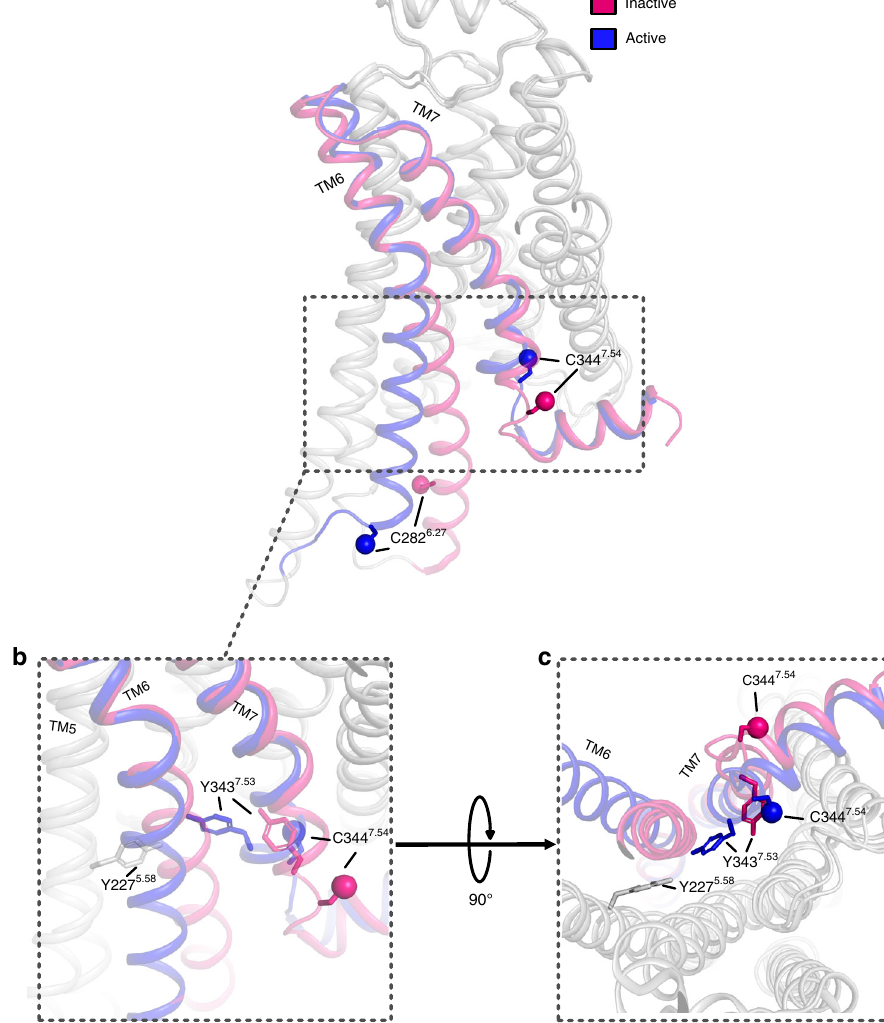
Fig. 1 Structure overlay illustrating conformational changes in β 1 AR upon activation. a Side-on view of β 1 AR bound to cyanopindolol, representative of the inactive state (magenta, PDB code 2YCY), and the nanobody Nb80 coupled receptor bound to isoprenaline, showing β 1 AR in the fully active state (blue, PDB code 6H7J). TM6, TM7 and helix 8 are shown in the colour of their respective state, with the G s mimetic nanobody omitted for purposes of clarity. The 19 F tagged cysteines A282C TET, 6.27 and TET C344 7.54 are shown with their side chains represented as sticks and the S γ atom as coloured spheres. The structure overlay highlights the outward movement of TM6 and the rotation of TM7 upon formation of the ternary complex. b Enlarged view showing the NPxxY 7.53 motif on TM7 containing the highly conserved Y343 7.53 that upon formation of the ternary complex rotates behind TM6 and makes a water- mediated hydrogen bond with Y227 5.58 on TM5 that stabilises the active state. Both Y343 7.53 and TET C344 7.54 rotate inwards upon formation of the ternary complex. c Cytoplasmic view of the region shown in ( b ), which illustrates the clockwise rotation of Y343 7.53 and TET C344 7.54 on